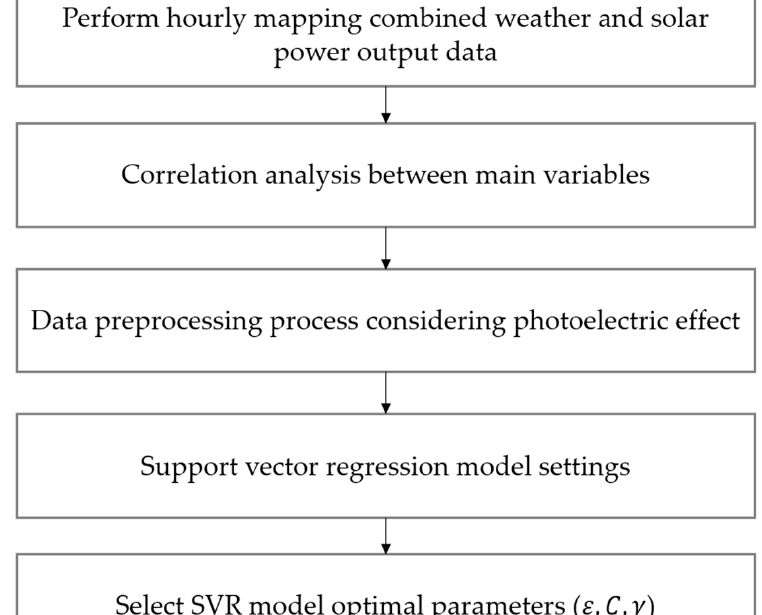
Figure 4. Algorithm for the SVR forecasting model.